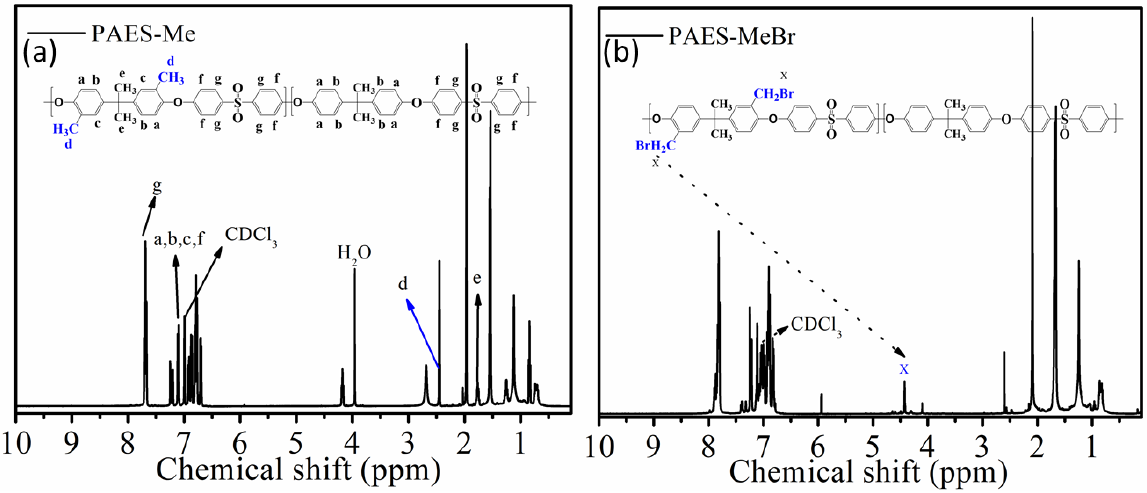
Figure 1. 1 H NMR spectra of ( a ) PAES-Me and ( b ) PAES-MeBr to confirm the stepwise functionali- zation of PAES, and ( c ) FT-IR spectra of three synthesized membranes, XPAES-DP, PAES-P, and PAES-TM. 2.2. Water Uptake and Swelling Ratio Water uptake and swelling ratio are important properties of the ion exchange mem- branes, as they significantly affect other membrane properties. In general, high water up- take enhances the ion conductivity but reduces the mechanical strength of the membrane. Thus, the establishment of high ion conductivity at low water uptake is highly pursued in the synthesis of ion exchange membranes in electrochemical applications, including fuel cells. The water uptake depends on the polymer backbone structure as well as the number and type of active functional groups attached on the polymer backbone. As shown in Fig- ure 2a, the lowest water uptake of 28.44% at 30 °C is displayed by XPAES-DP membrane because of the internal cross-linking via the formation of covalent bonds between the pol- ymer chains. This network structure prohibits the accommodation of a large amount of water molecules and thus results in relatively low water uptake without significant loss of mechanical strength of the membrane. The highest water uptake 34.65% at 30 °C and 56.42% at 80 °C are observed from PAES-P membrane. The higher water behavior of PAES-P than PAES-TM is caused by the hydrophilicity difference between the two func- tional groups, P and TM. The same trend is observed for the swelling ratio of the